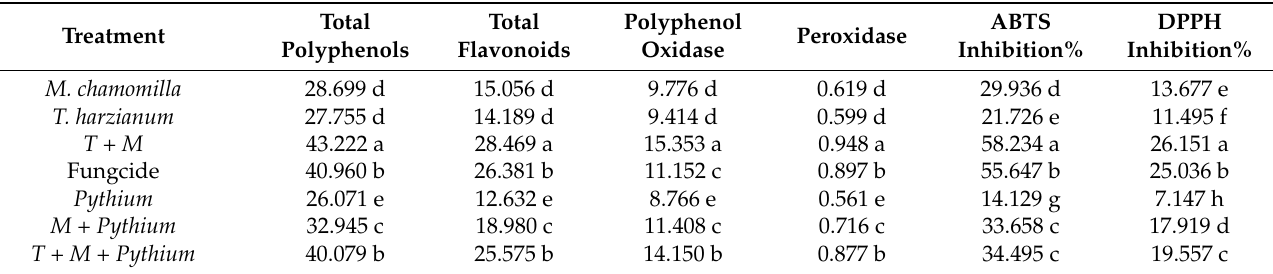
Table 3. Biochemical features of Phaseolus vulgaris plants as response of different